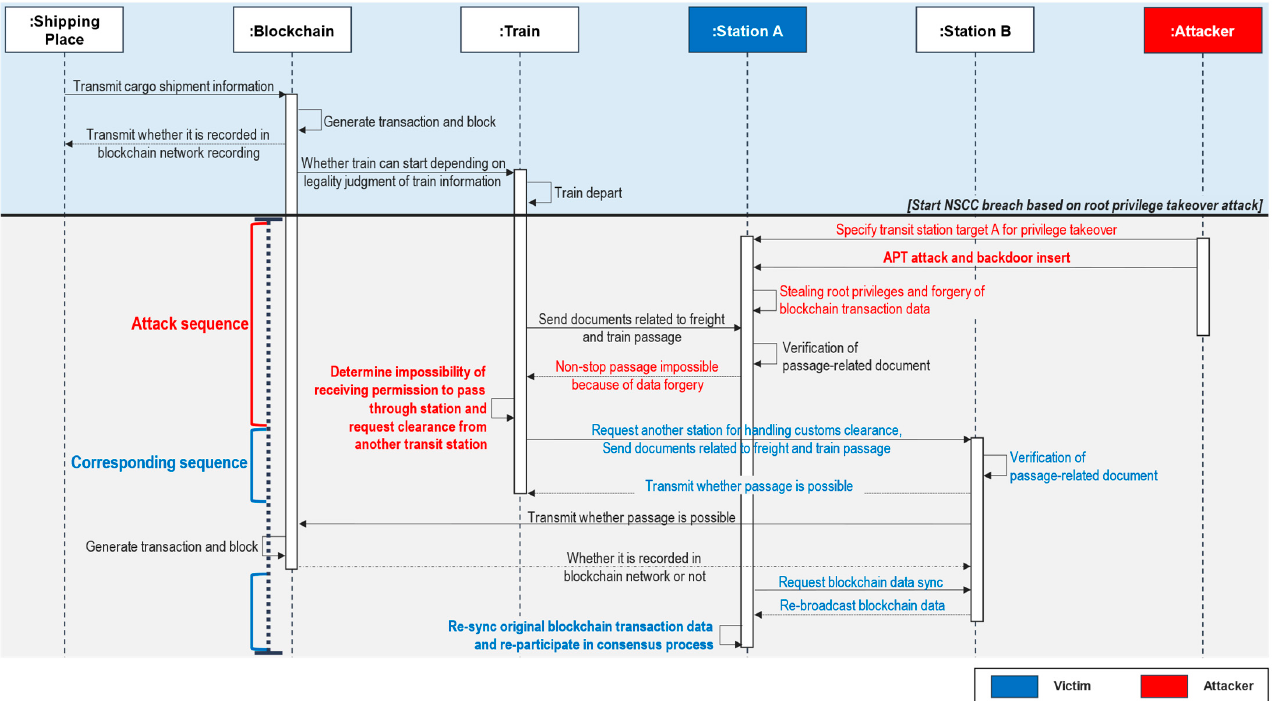
Figure 8. Attack sequence using root access privileges.